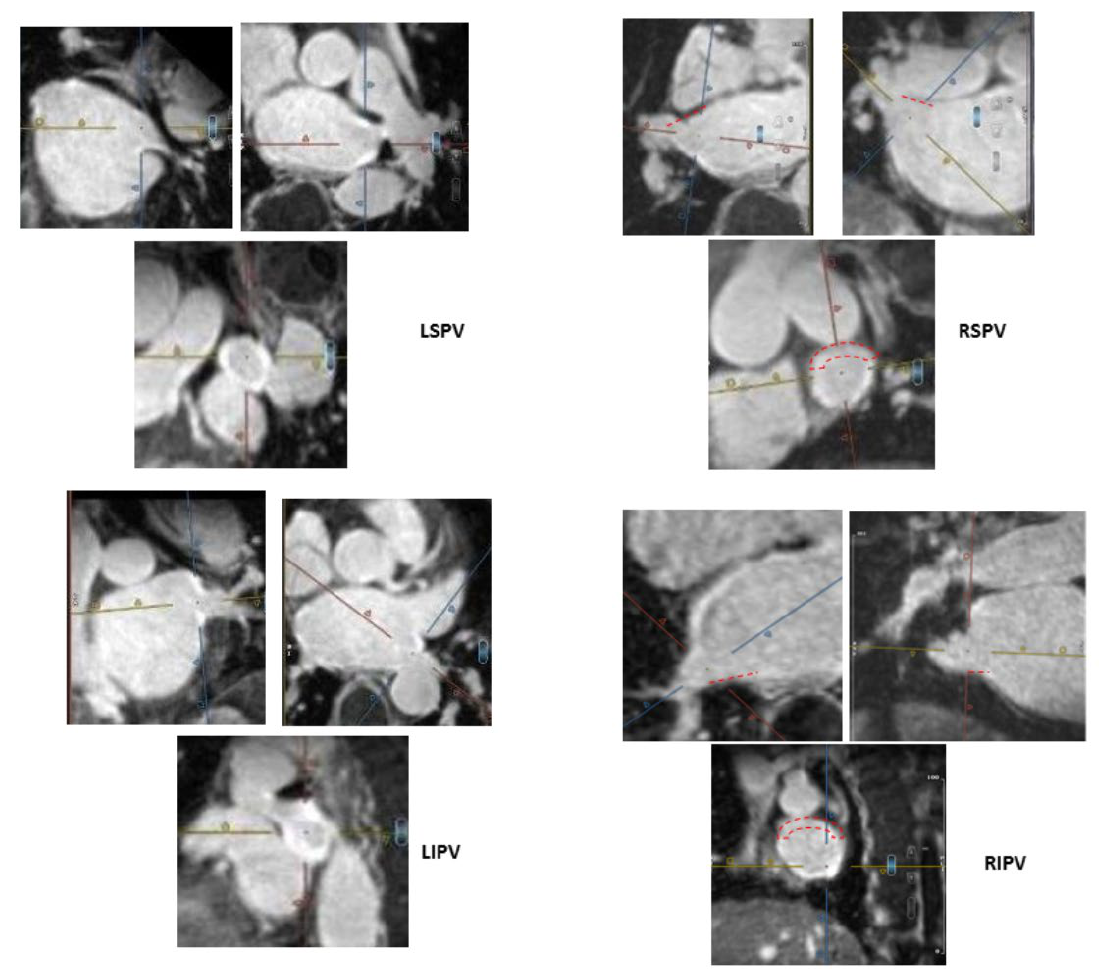
Figure 1. Cross-sectional short-axis views of PVs on post-ablation LGE MRI using the “double oblique” technique. For each PV, two orthogonal plane images are used to create its circular cross-sectional short-axis view. (PV are centered between the MRI orthogonal lines.) Each PV ostium was divided into four segments: anterior, posterior, roof, and floor. Based on the cross-sectional views of PV ostia, ablation-induced PV ostial fibrosis are categorized as complete circumferential fibrosis, sub-complete circumferential fibrosis with single “minor” gap defined as LGE gap ≤ 1/3 PV segment length, partial fibrosis with major gaps defined by as LGE gap > 1/3 segment length, or absent PV fibrosis. In this patient, both left PVs are fully encircled by LGE enhancement (seen as bold white lines), defined as complete PV circumferential fibrosis, while both right PVs have major gaps ( ) and thus are defined as partial incomplete circumferential PV ostial fibrosis. The right PV gaps are marked